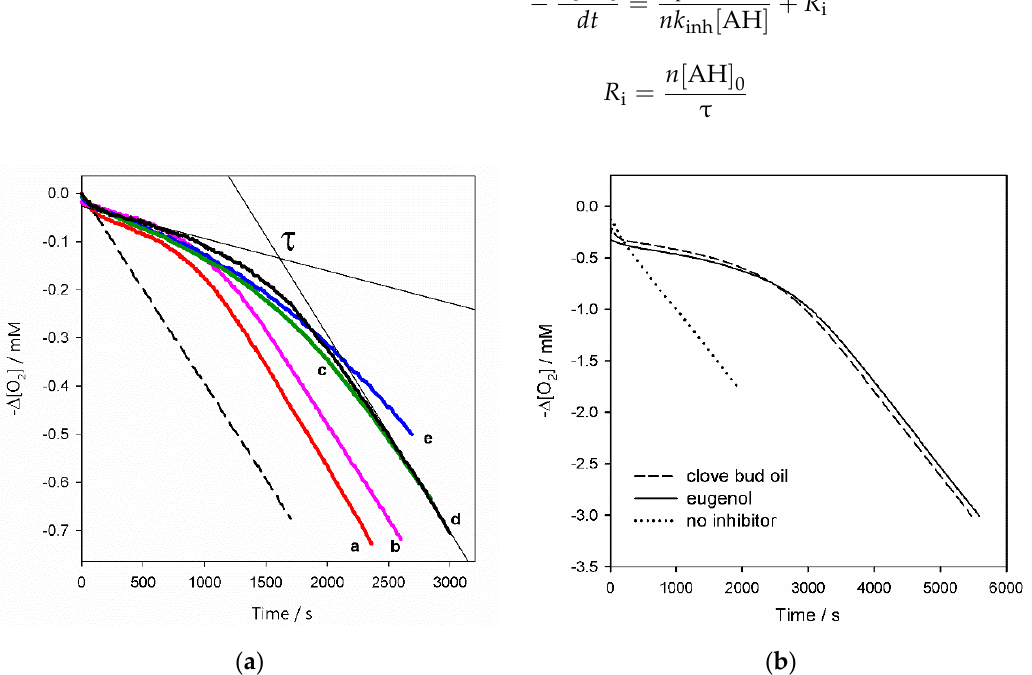
Figure 2. Oxygen consumption during the autoxidation of cumene (3.6 M) initiated by AIBN (0.05 M) in PhCl at 30 °C (panel a ) without inhibitors (dashed) or in the presence of EOs (1 mg/L): red thyme (a), savory (b), clove bud (c), oregano (d), cinnamon leaves (e); where inhibition time τ is determined at the cross-point between inhibited and uninhibited tracts as illustrated for plot (d); and (panel b ) without inhibitors (dotted), or in the presence of 1 mg/L eugenol (full), or clove bud oil (1.25 mg/L) dosed to provide 1 mg/L eugenol